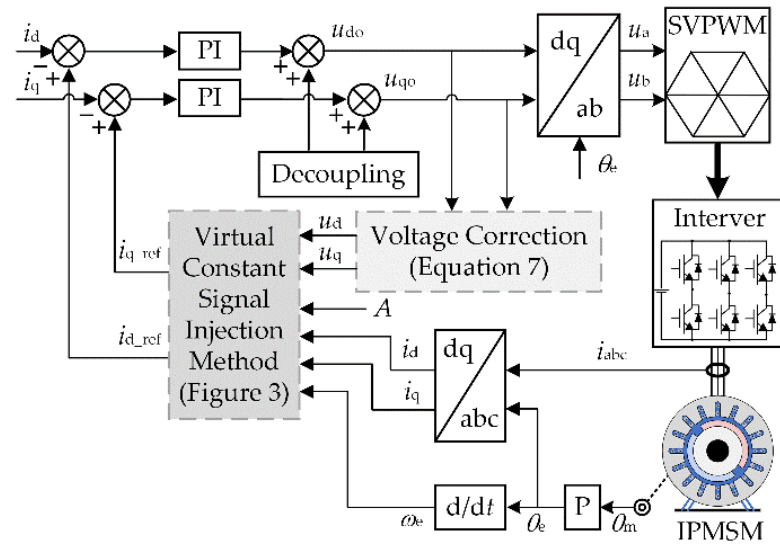
Figure 4. Block diagram of the whole proposed control scheme.